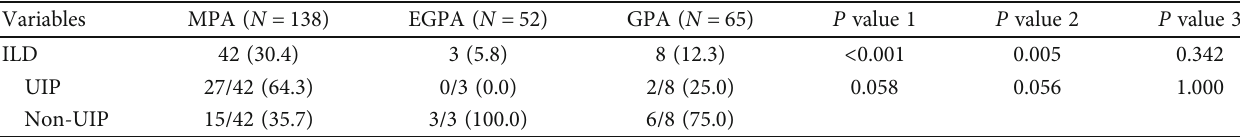
Values are expressed as a median N (%). P value 1: between MPA and EGPA groups. P value 2: between MPA and GPA groups. P value 3: between EGPA and GPA groups. ILD: interstitial lung disease; AAV: ANCA-associated vasculitis; ANCA: antineutrophil cytoplasmic antibody; MPA: microscopic polyangiitis; EGPA: eosinophilic granulomatosis with polyangiitis; GPA: granulomatosis with polyangiitis; UIP: usual interstitial pneumonia. Table 3: Comparison of ILD patterns according to ANCA type ( N = 255 ).